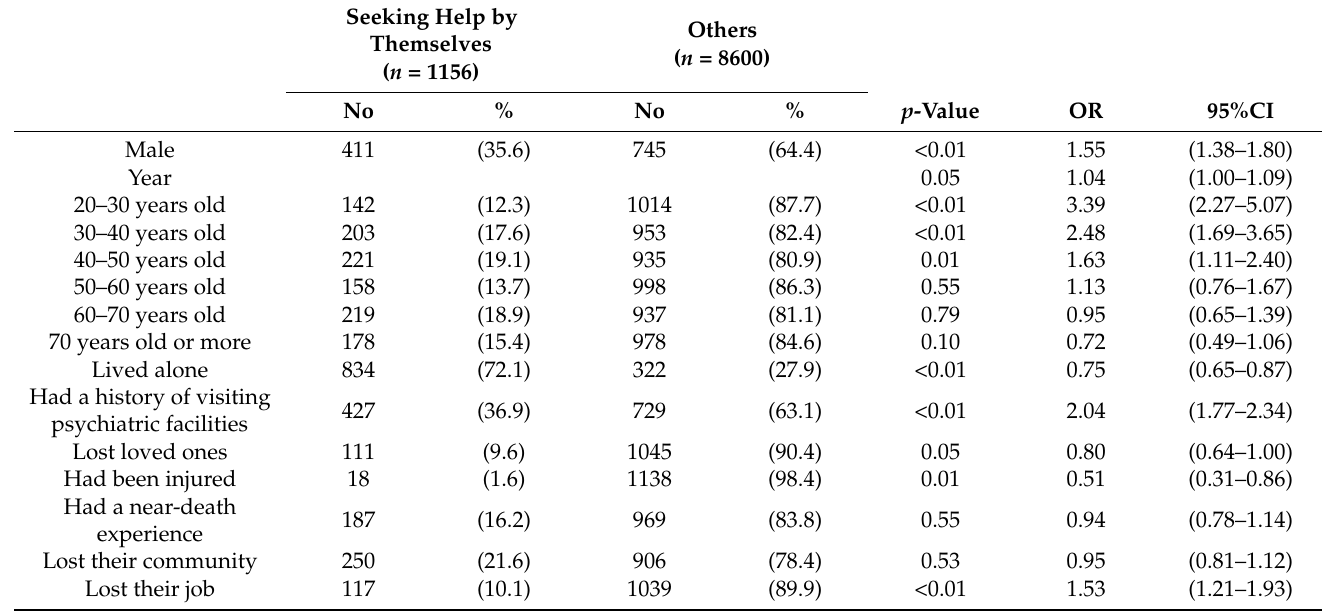
Table 2. Factors related to the residents who visited the center by themselves.